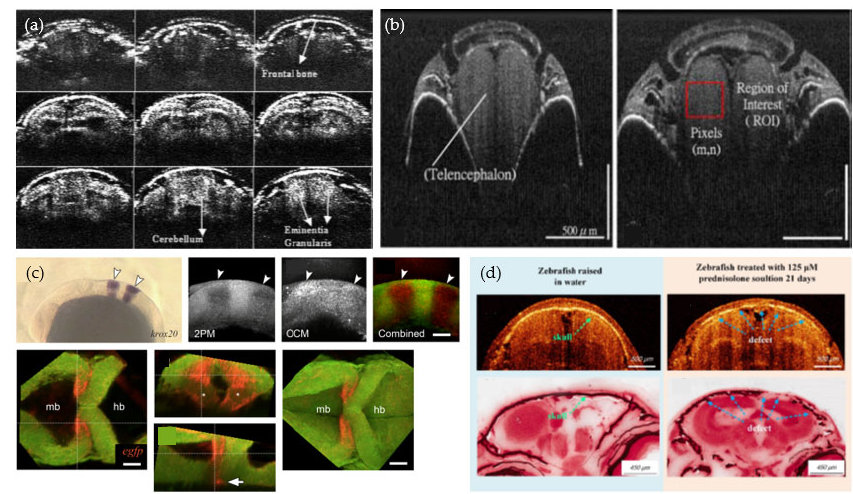
Figure 6. OCT studies performed in the zebrafish skull and brain. ( a ) In vivo brain imaging at 1310 ‐ nm [92]. Copyright Wiley ‐ VCH GmbH. Reproduced with permission. ( b ) Investigating the aging process of the zebrafish brain using OCT [95]. Copyright Wiley ‐ VCH GmbH. Reproduced with per ‐ mission. ( c ) Embryonic brain development examined with a multimodal OCT system [96]. Re ‐ print permission was granted under the Creative Commons (CC BY 3.0)—Gold Open Access by SPIE. ( d ) Osteoporotic process examine using OCT. Reprinted with permission from Lin et al. [97] © The Op ‐ tical Society.